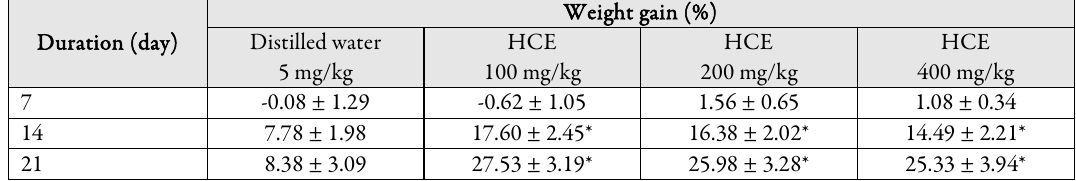
Table 1. Effects of HCE on percentage body weight gain of treated rats Duration (day)